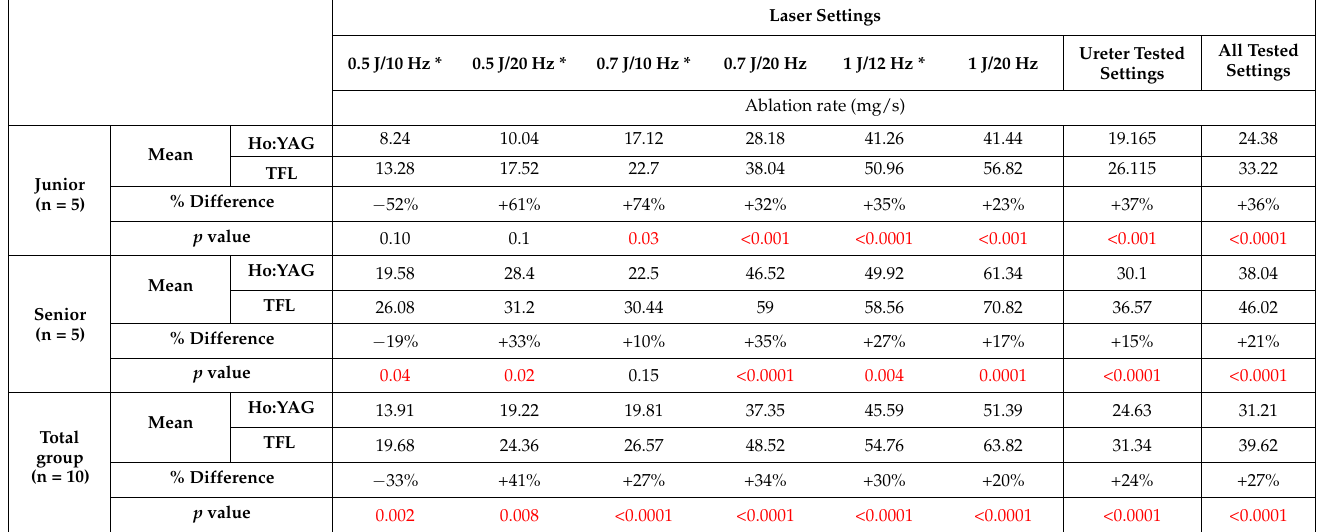
Table 1. Ablation rate (mg/s) of each scenario by Ho:YAG and TFL lasers, during 3 min of